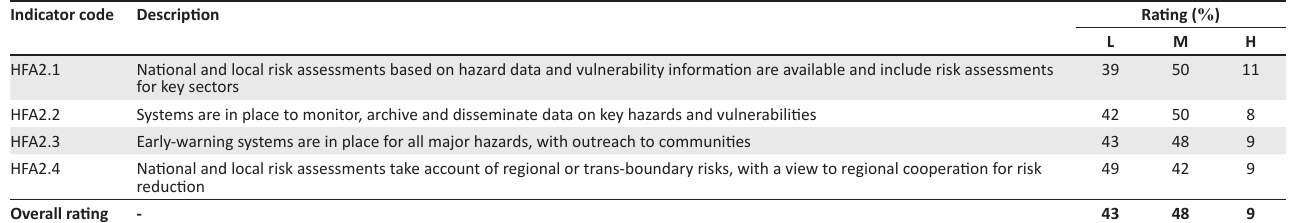
TABLE 3: Perceptions of respondents with regard to achieving Hyogo Framework for Action 2: Improving risk information and early warning. Indicator code Description